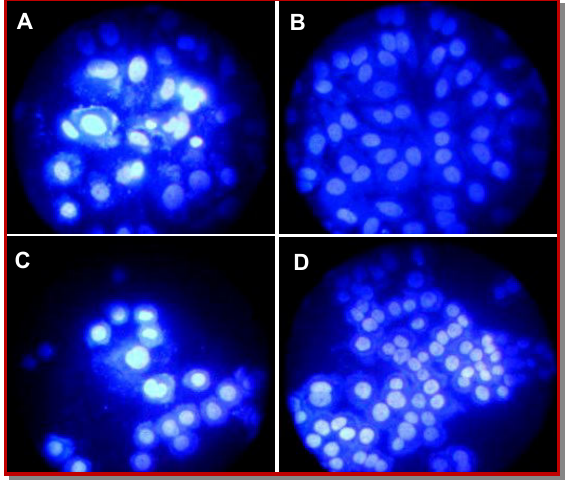
Figure 2: Hoechst 33258 staining in MCF-7 and MDA-MB- 468 cell lines. The cells were treated with 12 μ g/mL A. re- pens extract in MCF-7 (A), 50 μ g/mL A. repens extract in MDA-MB-468 cells (C), DMSO 1% as control in MCF-7 (B) and in MDA-MB-468 (D)